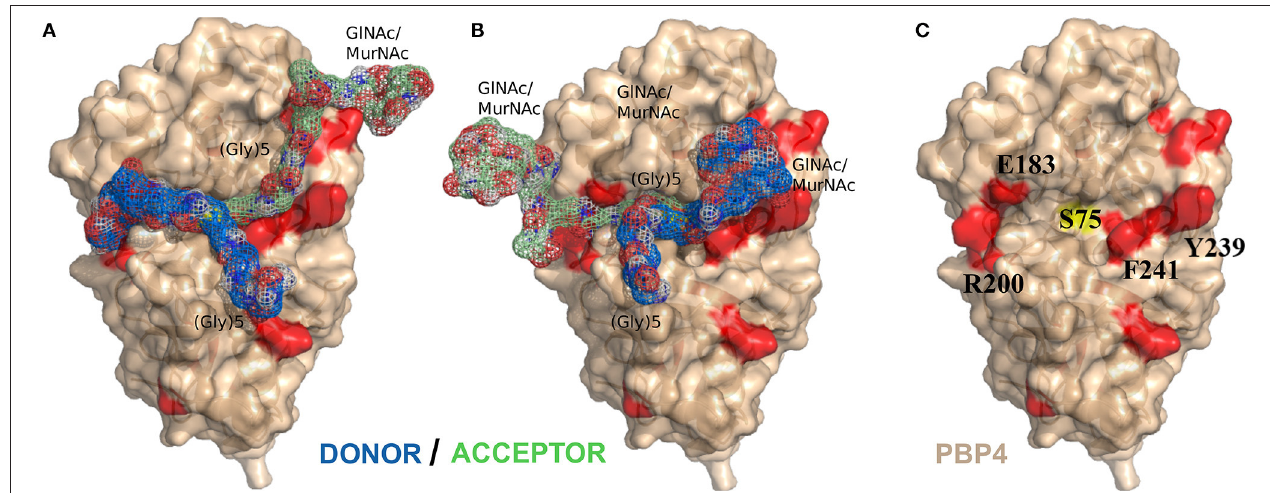
FIGURE 6 | NMR-data driven model of the PBP4:muropeptide complex. (A) Lowest energy structure of the optimal cluster solution obtained with HADDOCK (Haddock score of 93.5 ± 2.7). (B) Lowest energy structure of the second optimal cluster (Haddock score of − 93.3 ± 3.7). Donor and acceptor muropeptide substrates are colored in blue and green, respectively. (C) Surface representation of the structure of PBP4 in beige. Residues of PBP4 with significant NMR chemical shift perturbations and active site serine are colored in red and yellow, respectively. The residues highlighted show a side-chain reorientation between the PBP4 protein alone and in complex with